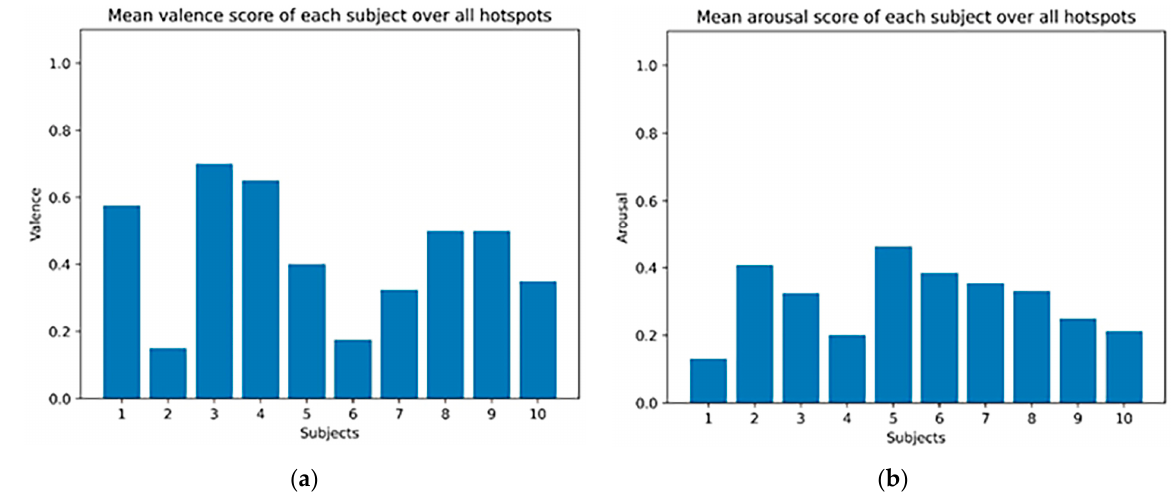
Figure 11. Mean ( a ) valence and ( b ) fused arousal per subject over all hotspots.